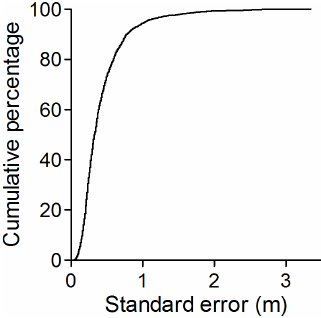
Fig. 4. Cumulative frequency distributions for the 2276 Himalayan glacial lakes against standard error of lake surface